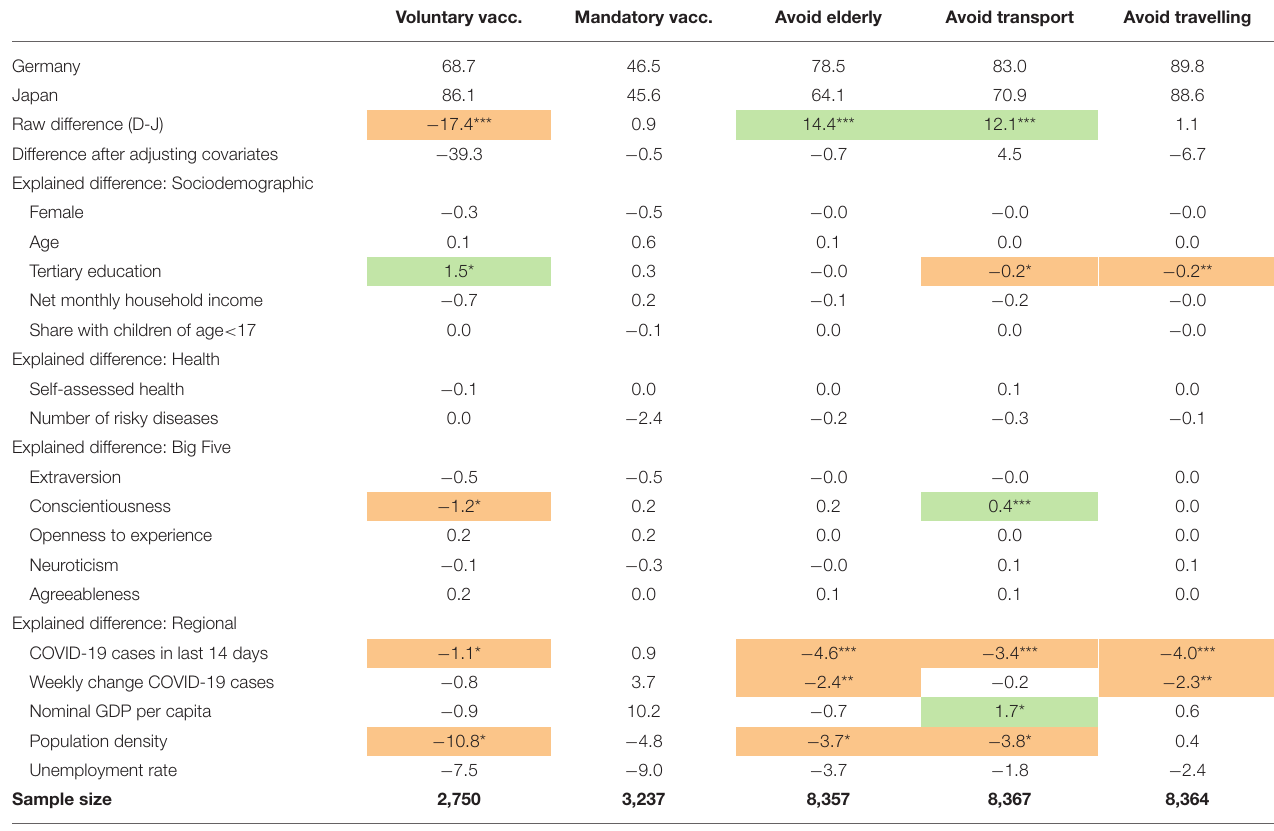
Table 4.1 | Contribution of differential endowments to differential attitudes and behaviors (1). Voluntary